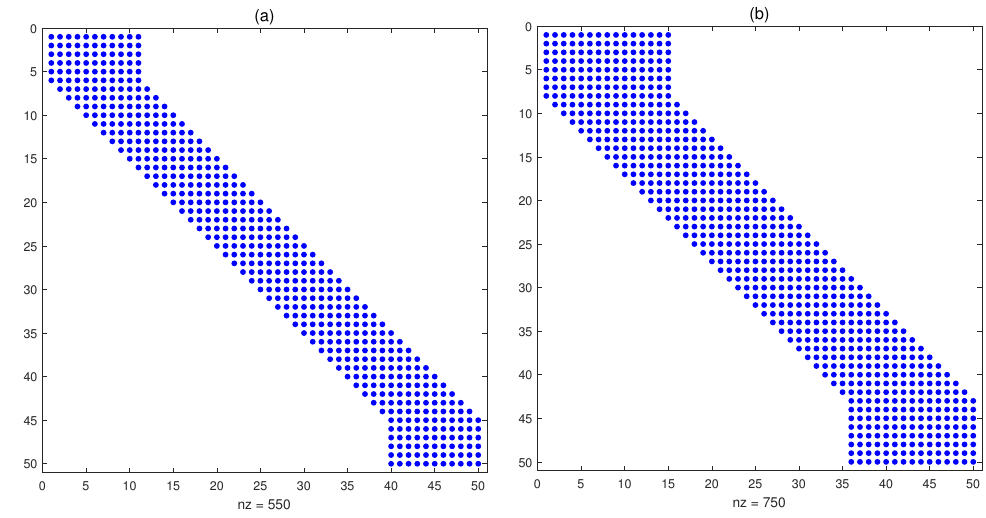
Figure 2. Sparsity patterns for N = 50 and two stencil sizes n i = 11 ( a ) and n i = 15 ( b